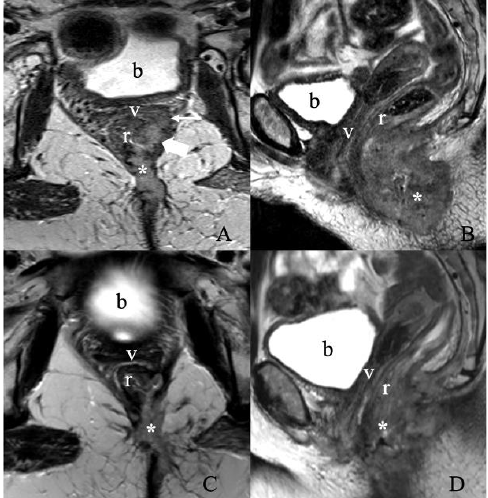
Figure 10. Lymph node evaluation and treatment in patients with vulvar cancer.